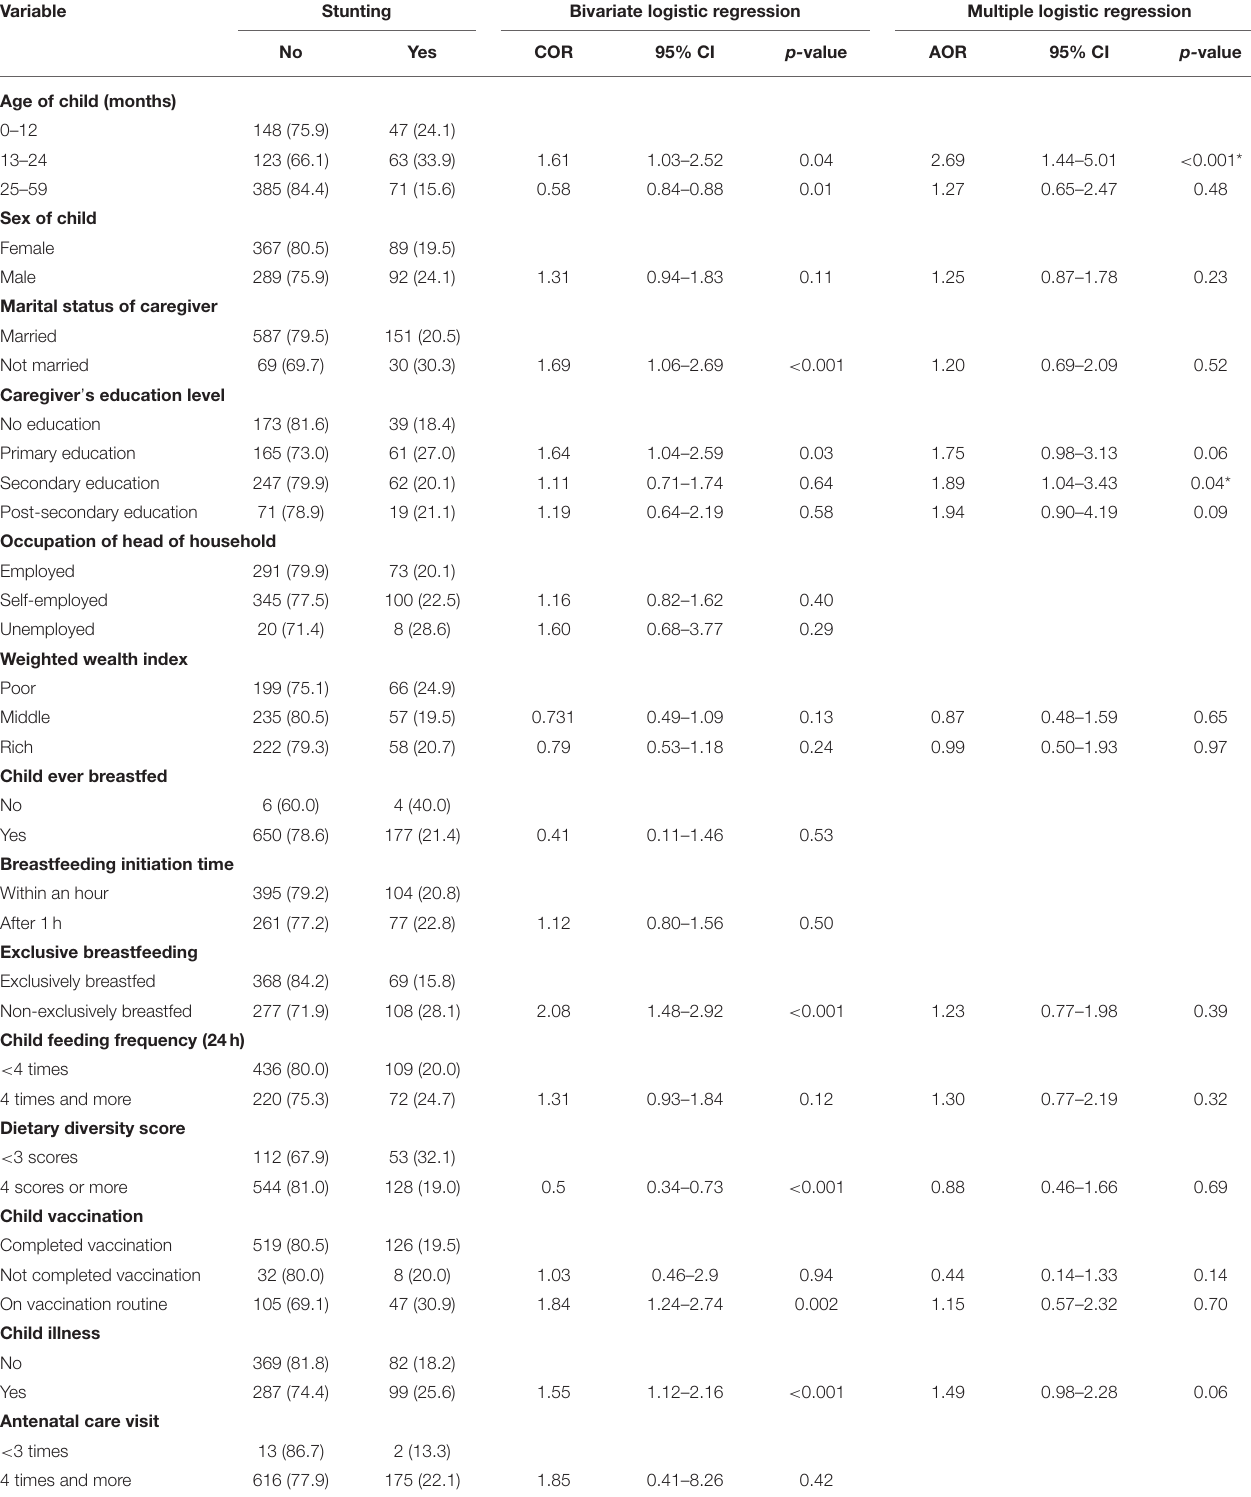
TABLE 2 | Bivariate and multiple logistic regression for factors associated with stunting (HAZ < − 2SD) among children age 0–59 months in Bambao region, July 2021 ( N = 837). Variable Stunting Bivariate logistic regression Multiple logistic